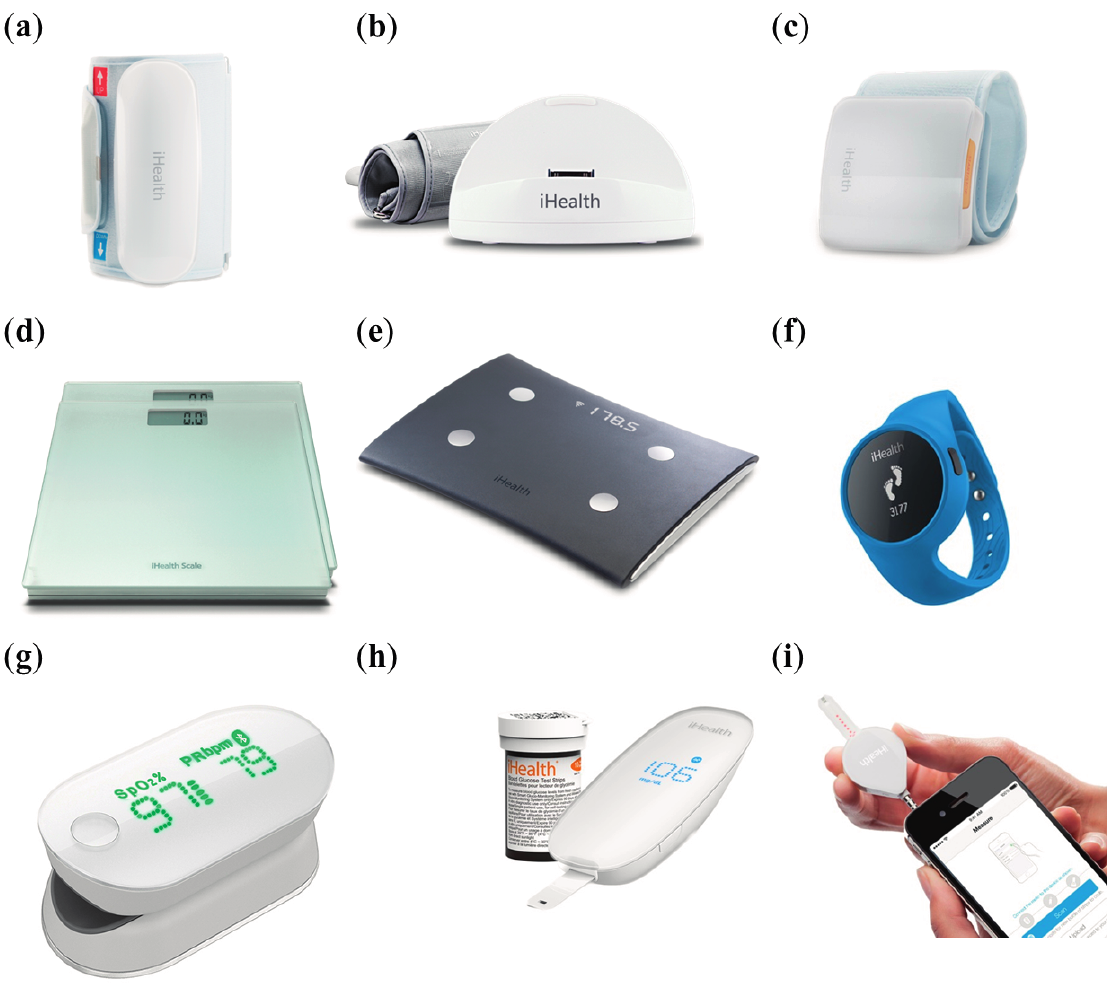
Figure 1. Smartphone-based devices (SBD) developed by iHealth Lab Inc. ( a ) Wireless blood pressure (BP) monitor; ( b ) iHealth BP dock; ( c ) wireless BP wrist monitor; ( d ) wireless digital scale; ( e ) wireless body analysis scale; ( f ) iHealth Wireless Activity and Sleep Tracker; ( g ) Wireless Pulse Oximeter; ( h ) iHealth Wireless Smart Gluco-Monitoring System; ( i ) iHealth Align. Reproduced with permission from iHealth Lab